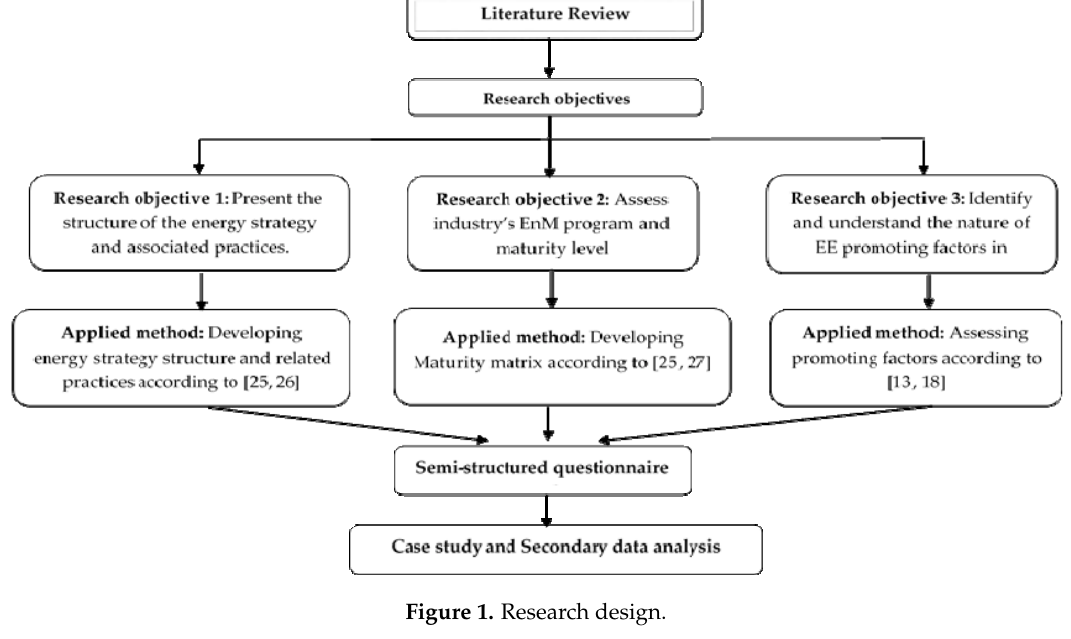
Figure 1. Research design.